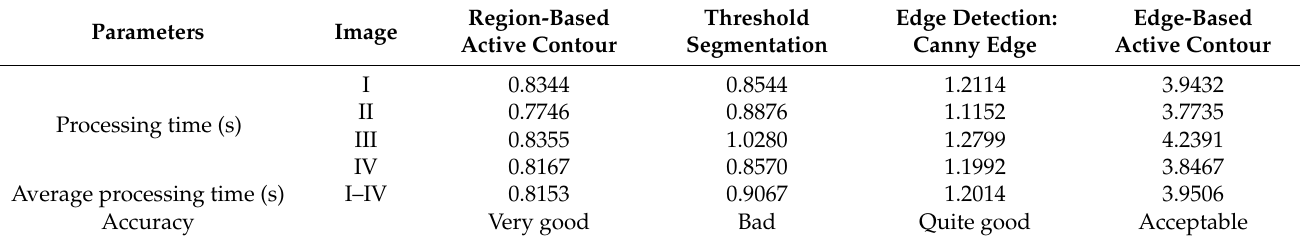
Table 5. Comparison of the processing times and precision of the four selected image processing algorithms. Parameters Image